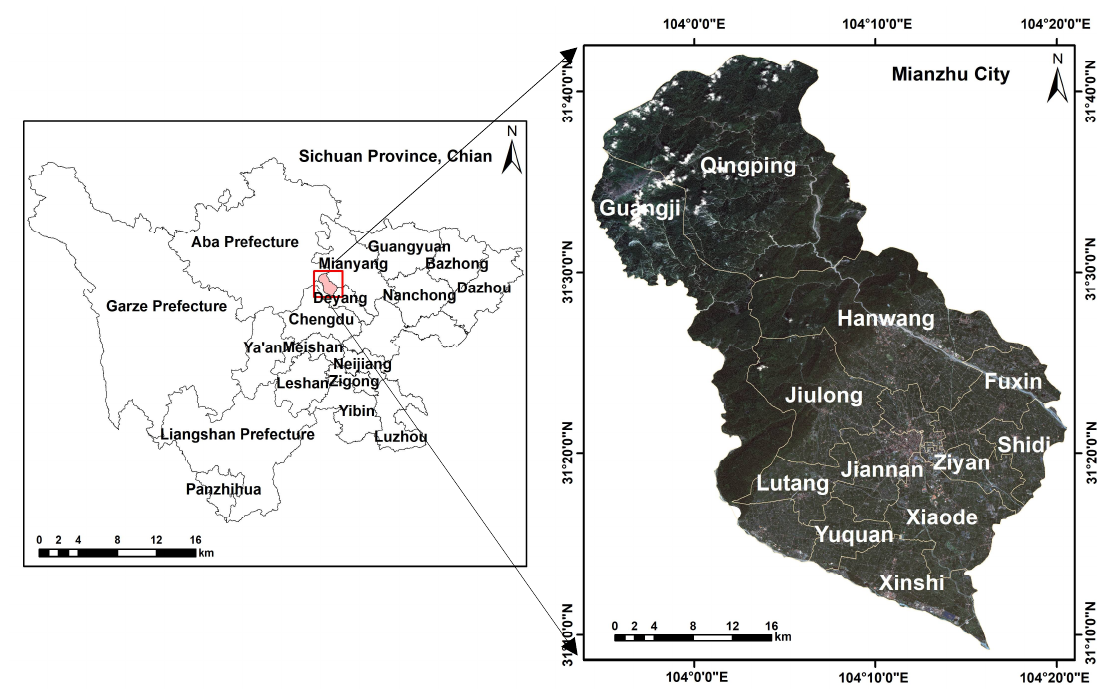
Figure 1. Location of the study area.